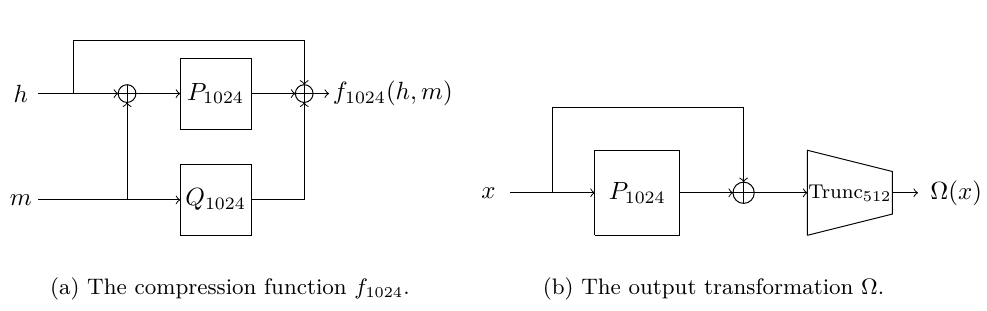
Figure 2: Grøstl-512 internal